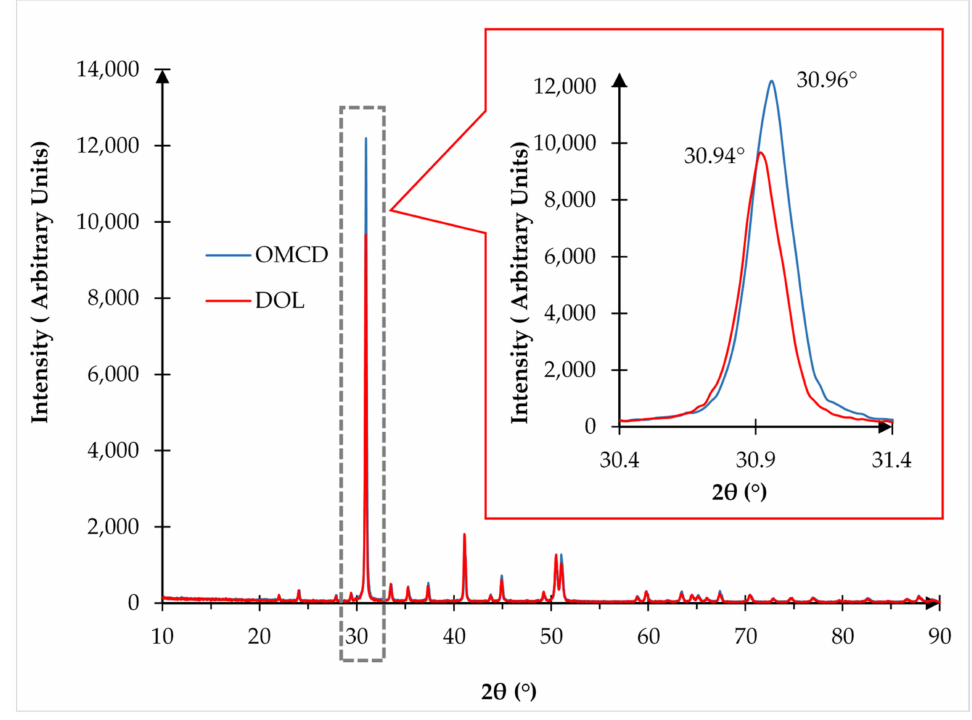
Figure 4. X-ray diffraction (XRD) pattern of PECoVA composites with different types of filler. The XRD pattern of dolomite (DOL and OMCD) reveals diffraction peaks at around 2 θ = 30.9122 ◦ and 30.9517 ◦ , which are similar to that observed by other researchers [19,28,29]. However, when benchmarked with the DOL, the OMCD shows more intense diffraction peaks at both angles. This signifies that the crystallinity of dolomite was enhanced by the planetary ball milling and the tip sonication process. This can be explained by the reduction in particle size of OMCD filler has increased its surface area and allow itself to arrange more closely packed compare to DOL filler. As a result, signal from X-ray diffracted from the crystalline lattices of OMCD filler particles become stronger. To prove this, the degree of crystallinity of both types of dolomite was measured and tabulated in Table 3. The degree of crystallinity for DOL and OMCD was found to be 76.57% and 77.10%, respectively. The higher degree of crystallinity of the OMCD could be as a result of the 10 h planetary ball milling and 2 h sonication process. The reduction in particle size of dolomite has increased its surface area. As a result, signals from XRD that went through the crystalline lattices of dolomite particles became stronger